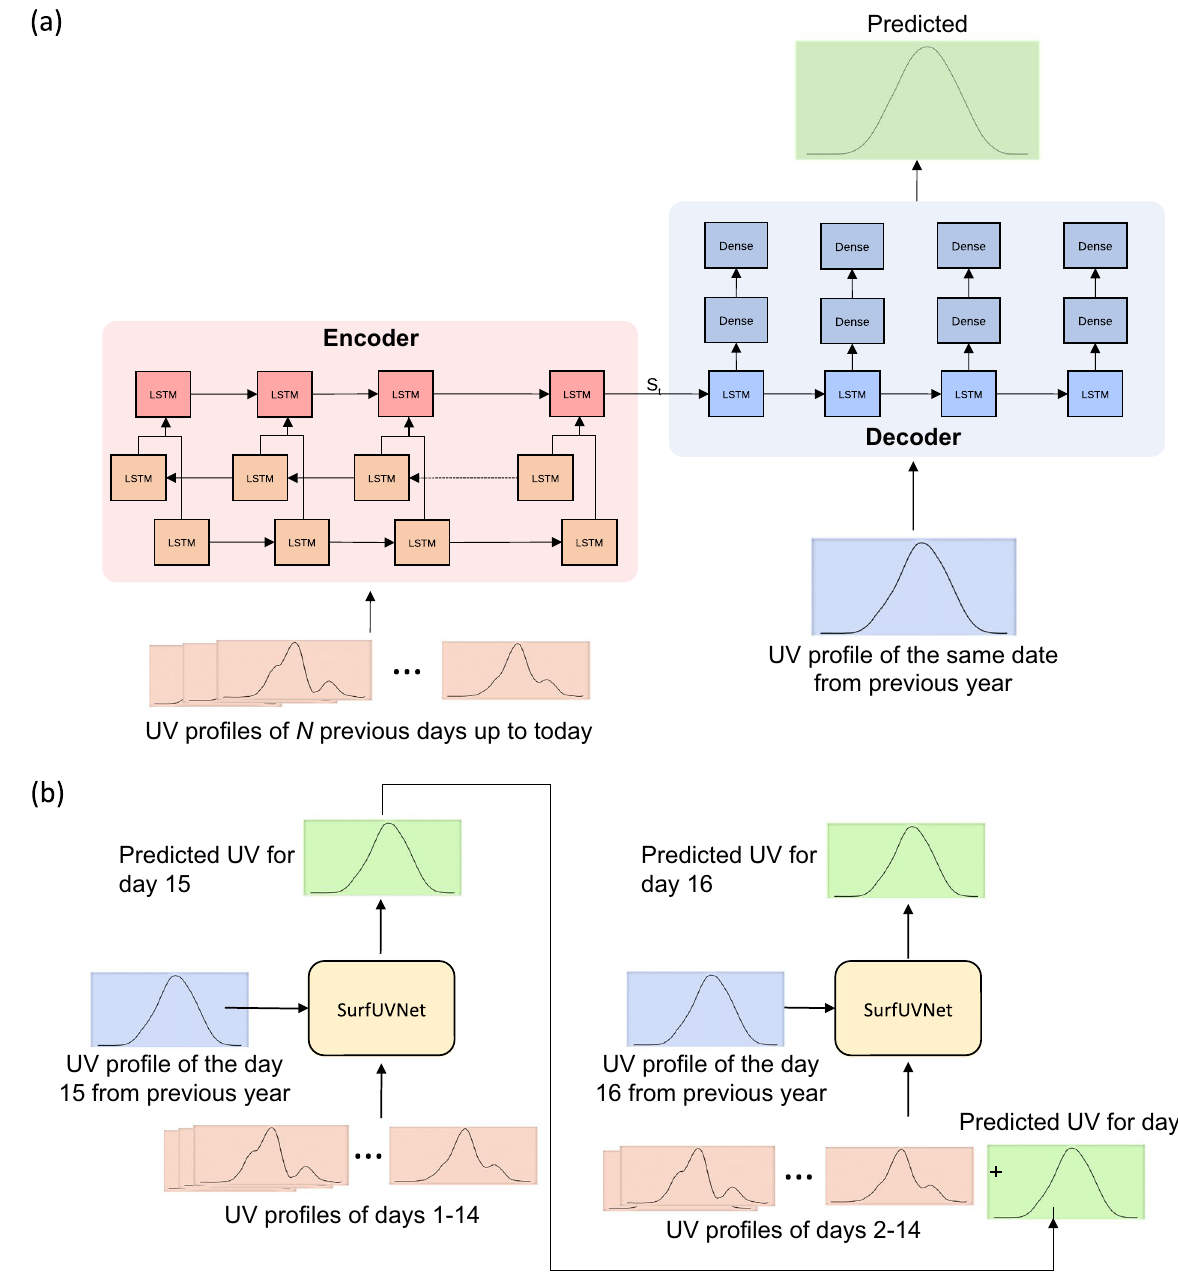
Figure 2. Schematic of SurfUVNet. ( a ) The underlying encoder–decoder neural network architecture showing the flow of data from the encoder to the decoder via the central connection denoted by S t . LSTM and Dense indicates the Long Short-Term Memory and fully connected neural network layers, respectively. UV data from days prior to the forecast date are fed into the encoder part while UV data from the same date of previous year are fed into the decoder part. The model forecasts next-day UV radiation at 10-min resolution. ( b ) The auto- recursive mode for long-term UV forecasting. To forecast UV radiation for the next N days, SurfUVNet